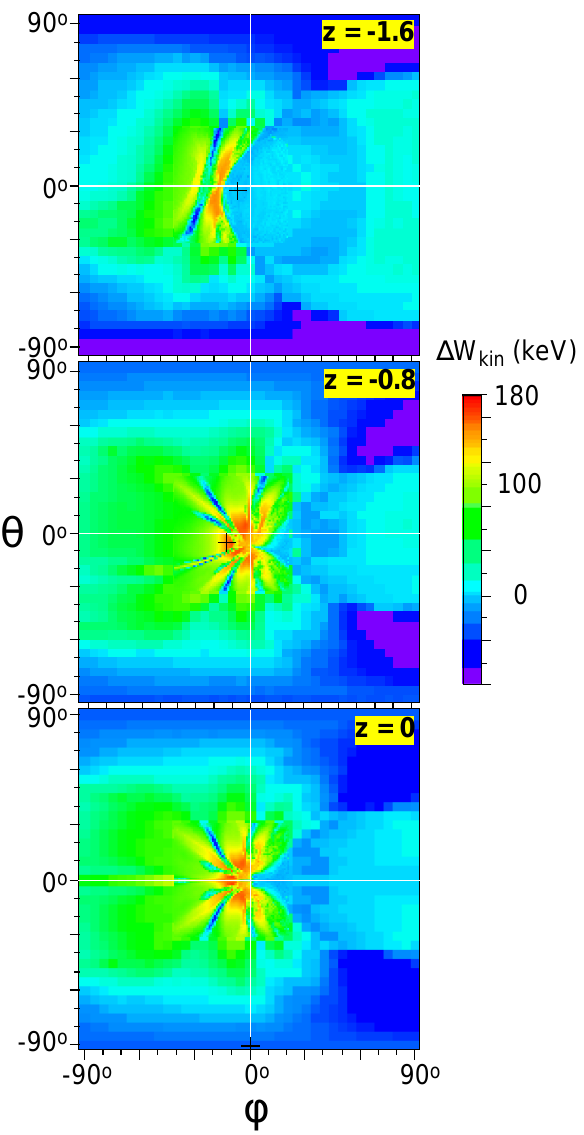
Fig. 12. Phase space distribution of 180 keV O + fluxes in the tail- ward direction at x =− 55 ,y = 5 and three locations in z for t = 9min. The color-coding again represents the energy gain of ions traced backwards in time from the given phase space location, taken as a measure of the flux. The black crosses represent the local magnetic field direction at each location.